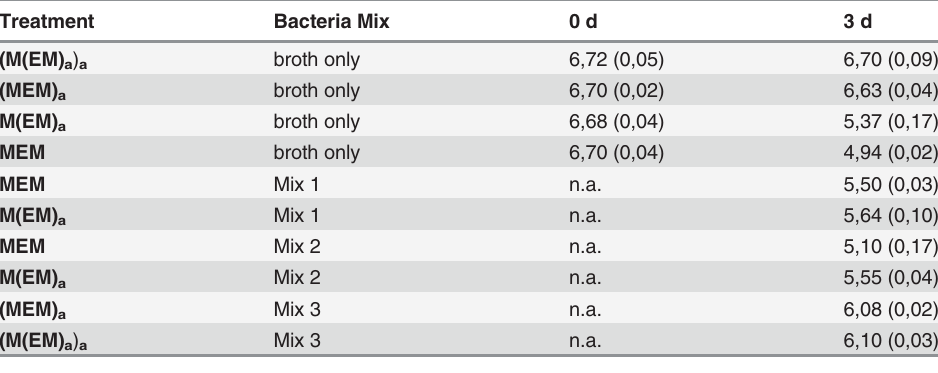
Most of the VFAs slightly inhibit growth of S . aureus but were not bactericidal at this pH and concentration. Although the most substantial, nearly bacteriostatic, effect of the mixture was caused by acetic acid, a combination of all VFAs plus ethanol tended to be more effective than acetic acid alone. Lactic acid alone at pH 5.3 appeared to support the growth of S . aureus . Inactivation of the ECBO virus Active ECBO virus was reduced from 5.49 log cpe/ ml to below the detection limit of 3 log 10 10 cpe/ml within 14 and 7 days fermentation of non-autoclaved manure treatments MEM and M , respectively, either with or without EM supplementation in starter cultures. (EM) a Table 6. pH of treatments MEM, M(EM) a , (MEM) a and (M(EM) a ) a at the start and after 3 days fermentation with different pathogen mixes. Treatment